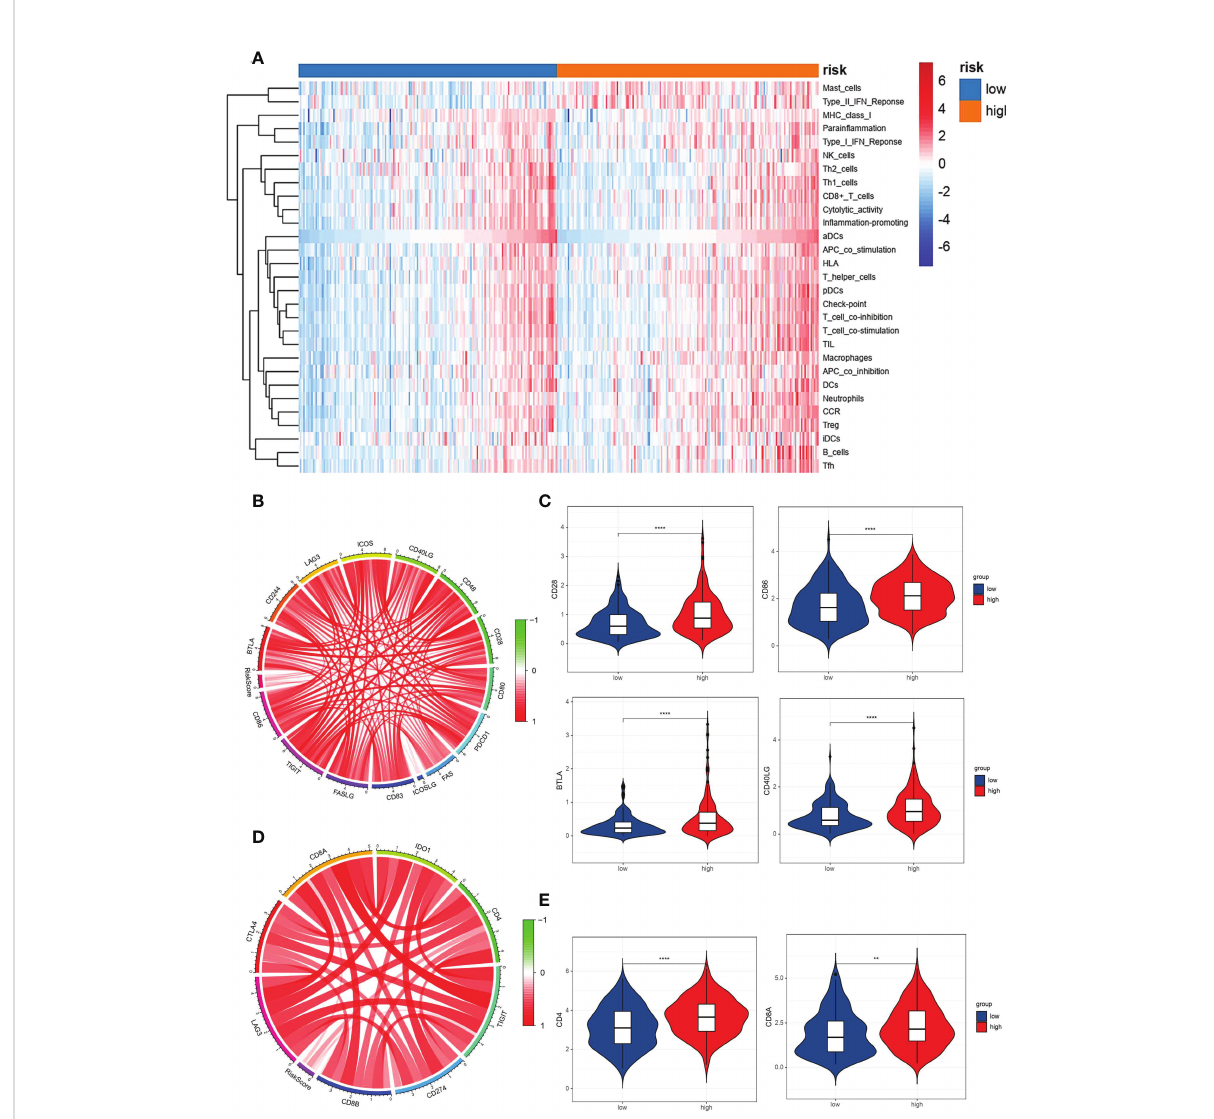
FIGURE 5 Correlation analysis between the VM index, immune cells in fi ltration in GC and pivotal immunotherapy-associated molecules. (A) Heatmap for immune cell in fi ltration in GC clustered by VM index. Red color represents positive correlation and blue color represents negative correlation. Relationship between VM index expression and immune cell in fi ltration. (B, D) Circular plots showed that VM index was correlated with immunotherapy-associated molecules in TCGA database; (C, E) Higher VM index was correlated with higher expression of immune checkpoints in GC, including CD28, CD86, BTLA, CD40LG, CD4 and CD8A. ** means P < 0.01, **** means